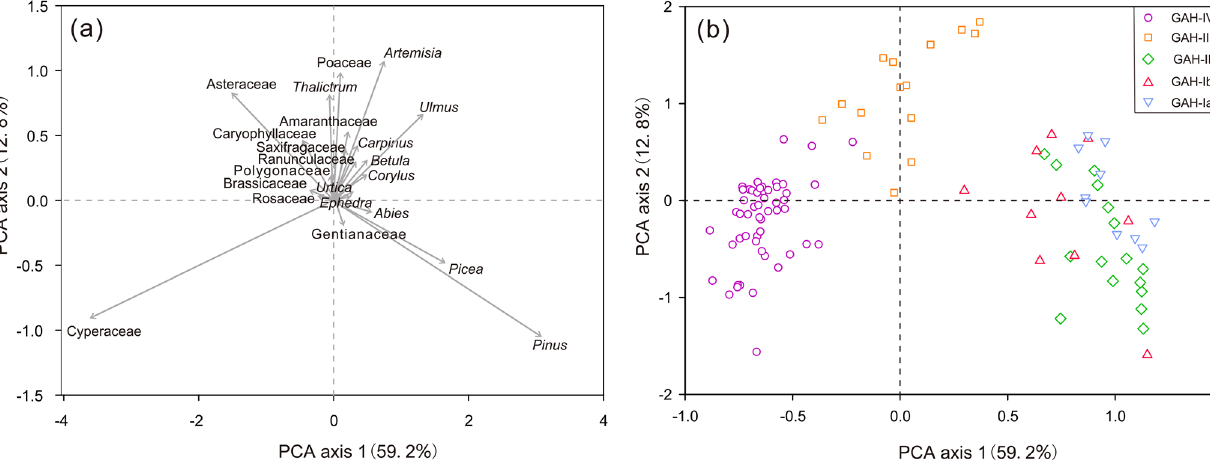
Figure 6. Principal component analysis (PCA) of fossil pollen taxa (a) and pollen zones (b) from Gahai Lake (see Fig. 5 for the pollen